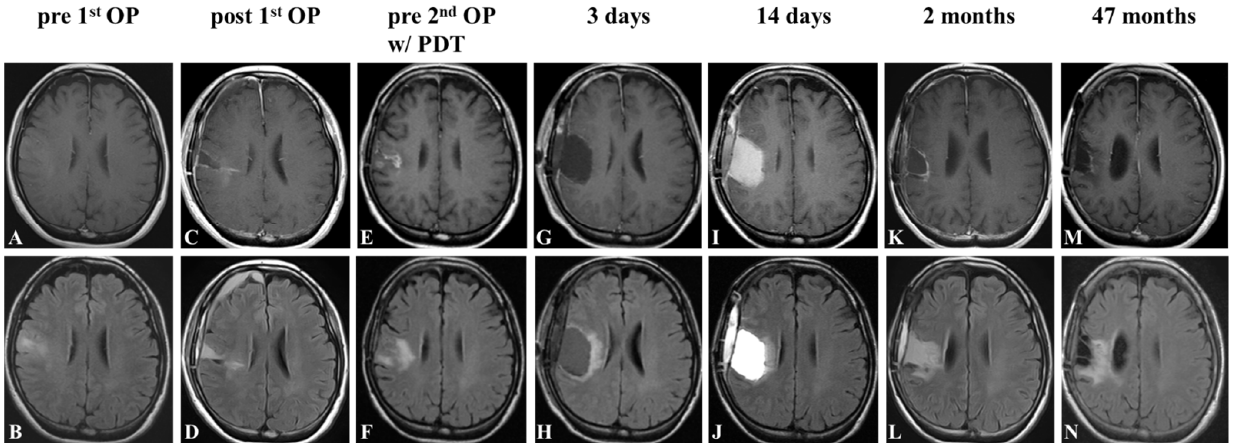
Figure 5. Representative Case 1. Contrast-enhanced T1-weighted and FLAIR MR image before ( A , B ) and after ( C , D ) the first operation. Contrast-enhanced T1-weighted and FLAIR findings before the second operation with PDT ( E , F ); 3 days ( G , H ); 2 weeks ( I , J ); 2 months ( K , L ), and 47 months ( M , N ) after the second